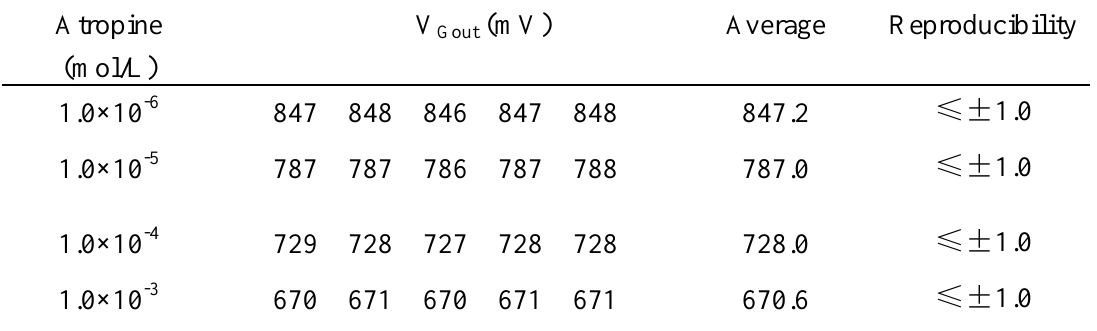
Table 3. Reproducibility of the sensor.